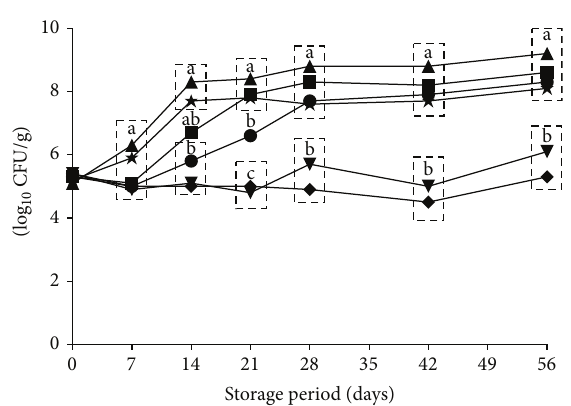
Figure 1: Inhibition of streptomycin-resistant (1500 𝜇 g/mL) Listeria monocytogenes Scott A on fully cooked uncured deli turkey slices treated by organic acid postcook dips applied singly or in com- bination, packaged and stored aerobically at 4 ∘ C. Symbols depict means from triplicate identical replications ( 𝑛 = 3), pooled by treatment: 3.6% sodium lactate ( e ), 3.6% potassium lactate ( ◼ ), 0.75% sodium citrate ( 󳵳 ), 3.6% sodium lactate + 0.25% sodium diacetate ( 󳶃 ), 3.6% sodium lactate + 3.6% potassium lactate + 0.25% sodiumdiacetate( X ),andinoculated,nontreatedcontrol( 󳀅 ).Sliced product was treated by 1min dip exposure to antimicrobial dips and then aseptically handled for enumeration of L. monocytogenes on streptomycin (1500 𝜇 g/mL) supplemented brain heart infusion (BHI) agar following 24hr incubation of inoculated Petri plates at 37 ∘ C. Symbols enclosed within dashed boxes do not differ at 𝑝 < 0.05 , while sampling day-specific pooled treatment means bearing differing letters (a, b, c) differ at 𝑝 < 0.05